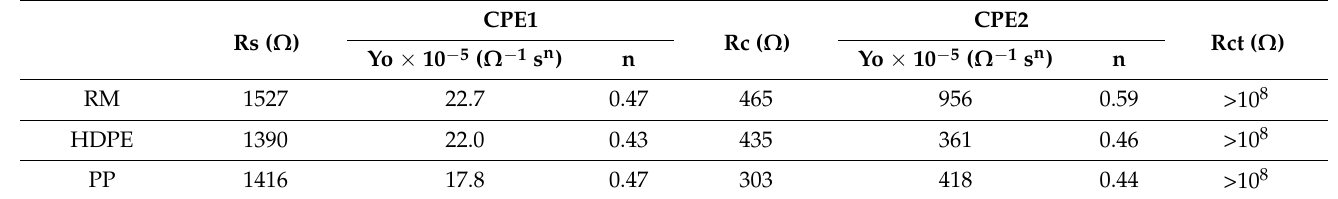
Table 4. Parameters obtained by equivalent circuit fitting (average of three